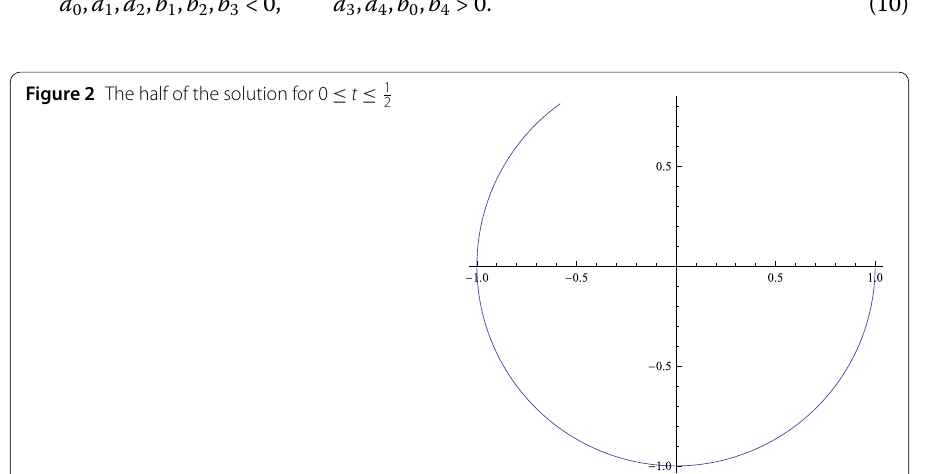
Figure 2 The half of the solution for 0 ≤ t ≤ 1